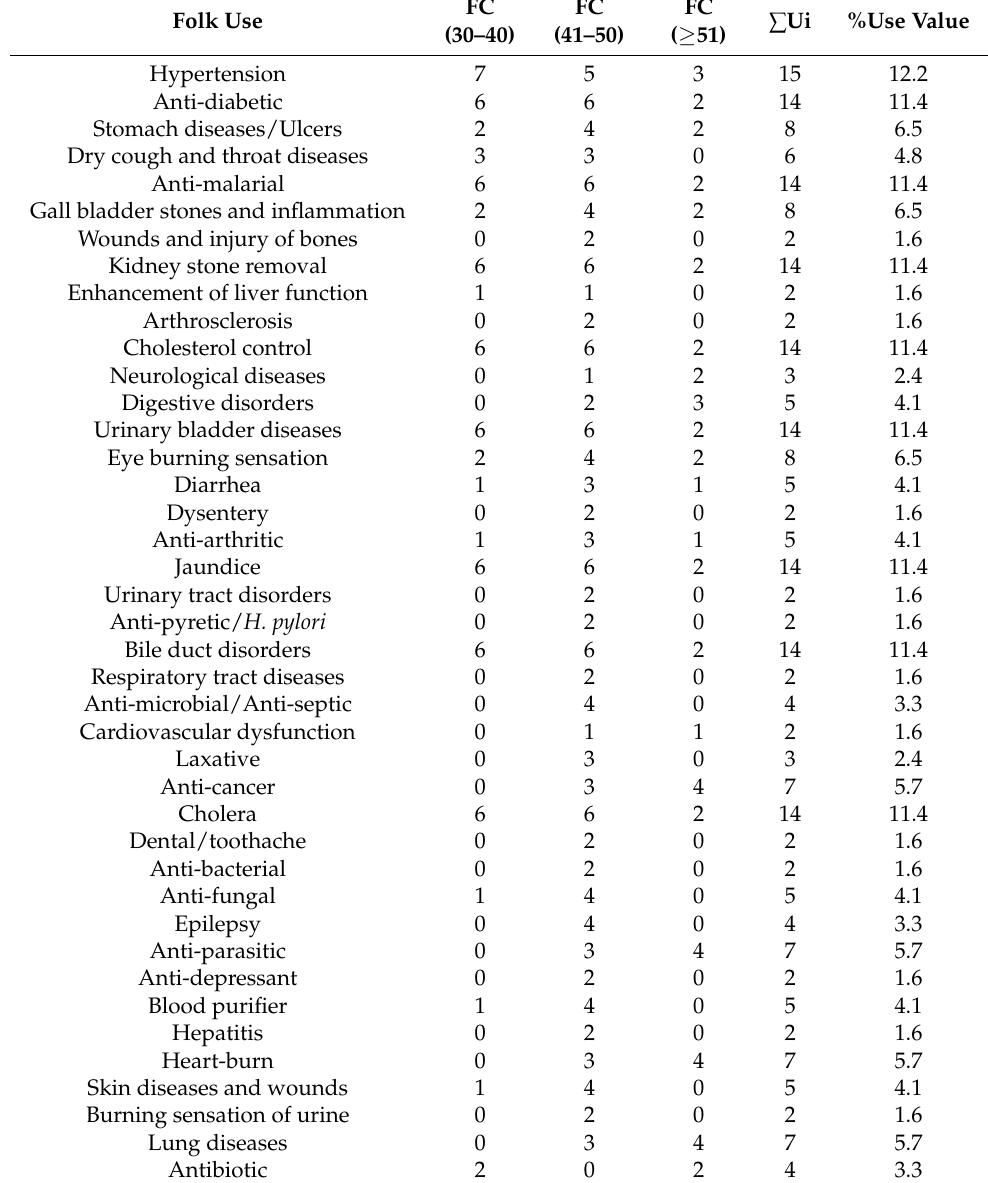
Table 1. Response of different age groups regarding the folk uses of Berberis lyceum Royle for curing different